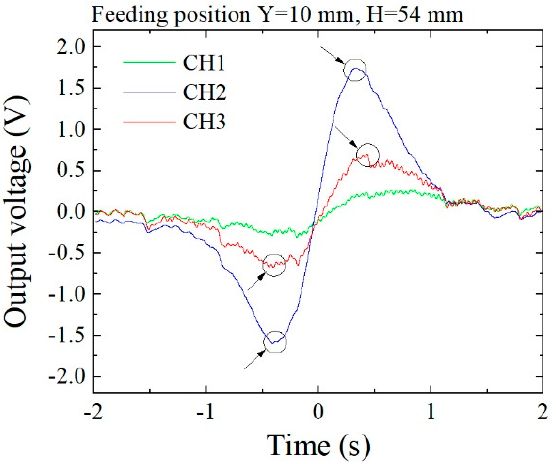
Figure 21. Measured waveforms (feeding point: y = 10, z = 54).